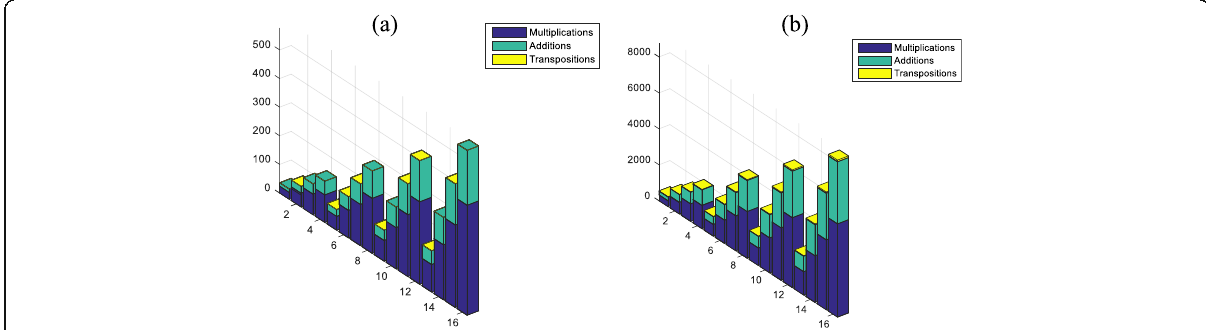
Fig. 8 The computational efficiency ( a ) the proposed method ( b ) the Euler rotation